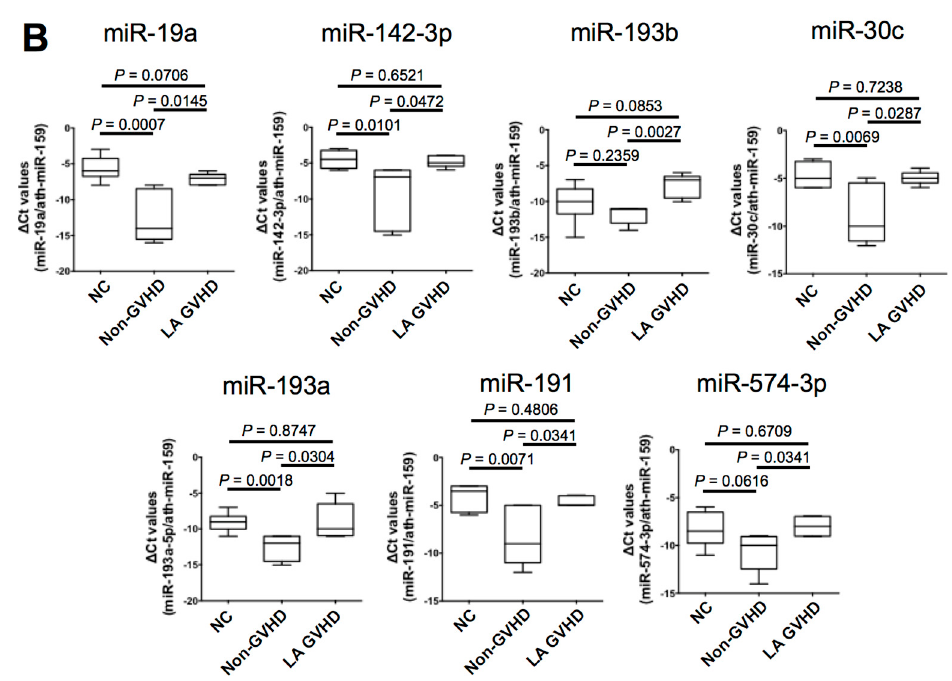
Figure 3. This microRNA expression according to late-onset acute GVHD (LA GVHD) vs. non-GVHD vs. normal controls at the onset of late-onset acute GVHD. Box plots depict the 75th percentile, median, and 25th percentile values; and whiskers represent minimum to maximum expression. p values were calculated using the independent two-sample t -test. ( A ) The expression levels of three miRNAs (miR-128, miR-125b, and miR-423-5p) were significantly higher in the exosomes of LA GVHD than in normal controls. The expression level of miR-423-5p showed downregulation in the non-GVHD groups when compared with normal controls. Accordingly, two miRNAs (miR-128, miR-125b) were chosen as candidate miRNAs specific for LA GVHD. ( B ) No significant differences of expression of seven miRNAs (miR-19a, miR-142-3p, miR-193b, miR-30c, miR-193a, miR-191, and miR-574-3p) were observed between LA GVHD and normal controls.